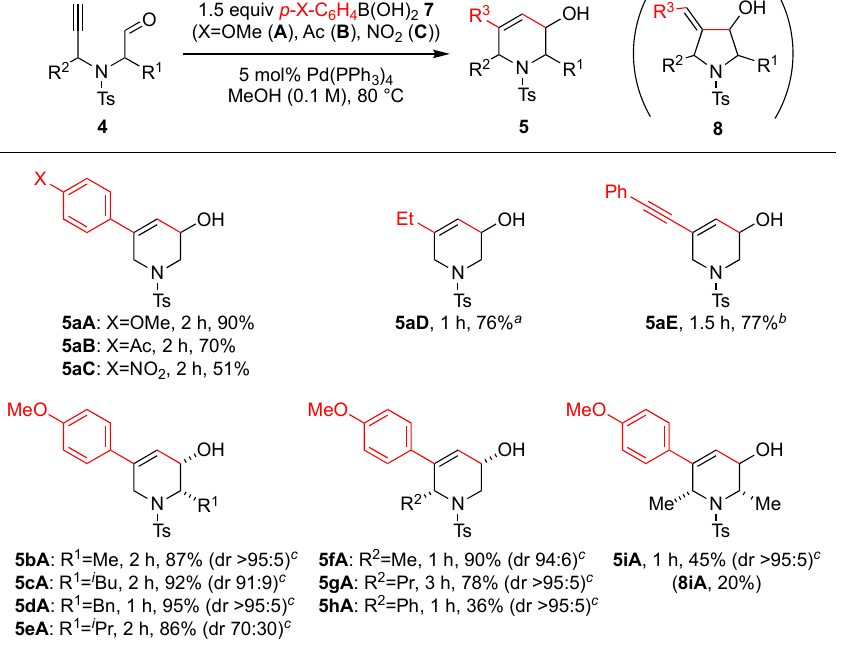
transition state for cis isomer (favored)